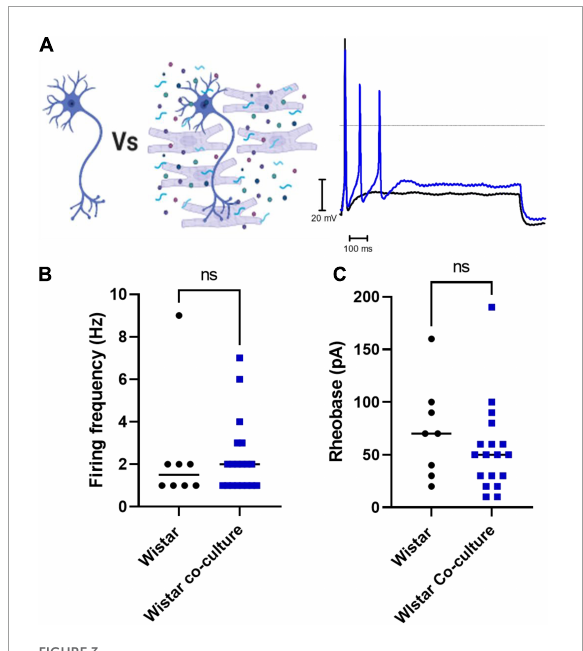
FIGURE3 Co-culture of Wistar neurons with Wistar cardiomyocytes did not affect Wistar neuron excitability The effect of Wistar cardiomyocyte co-culture upon Wistar neuron excitability was tested here. There was no observed effect of Wistar cardiomyocyte culture upon Wistar neuron function. (A) Diagram demonstrating the experimental design. Here Wistar neurons (Black) were cultured with Wistar cardiomyocytes (Blue), and thus able to physically and/or chemically interact with the cardiomyocytes. Example traces of Wistar neurons cultured alone (Black) or with Wistar cardiomyocytes (Blue). (B) There was no significant difference in neuronal firing rate (C) (Mann–Whitney test; n = 8, n = 19, p = 0.6816) or rheobase (Mann–Whitney test; n = 8, n = 18, p = 0.2650) between Wistar neurons cultured alone or in co-culture